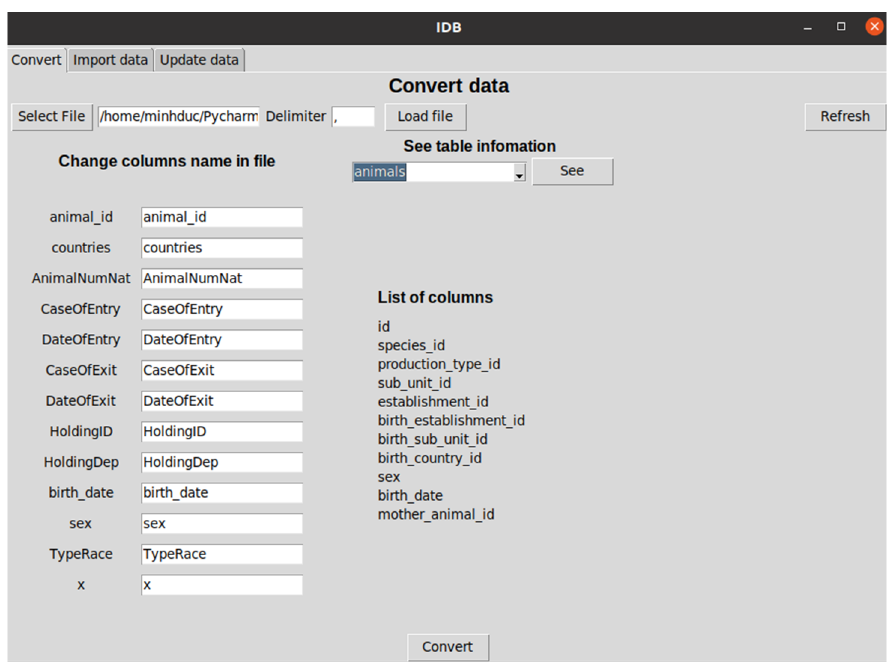
Figure 5. Graphical user interface of the SIGMA-based data model standardization software.